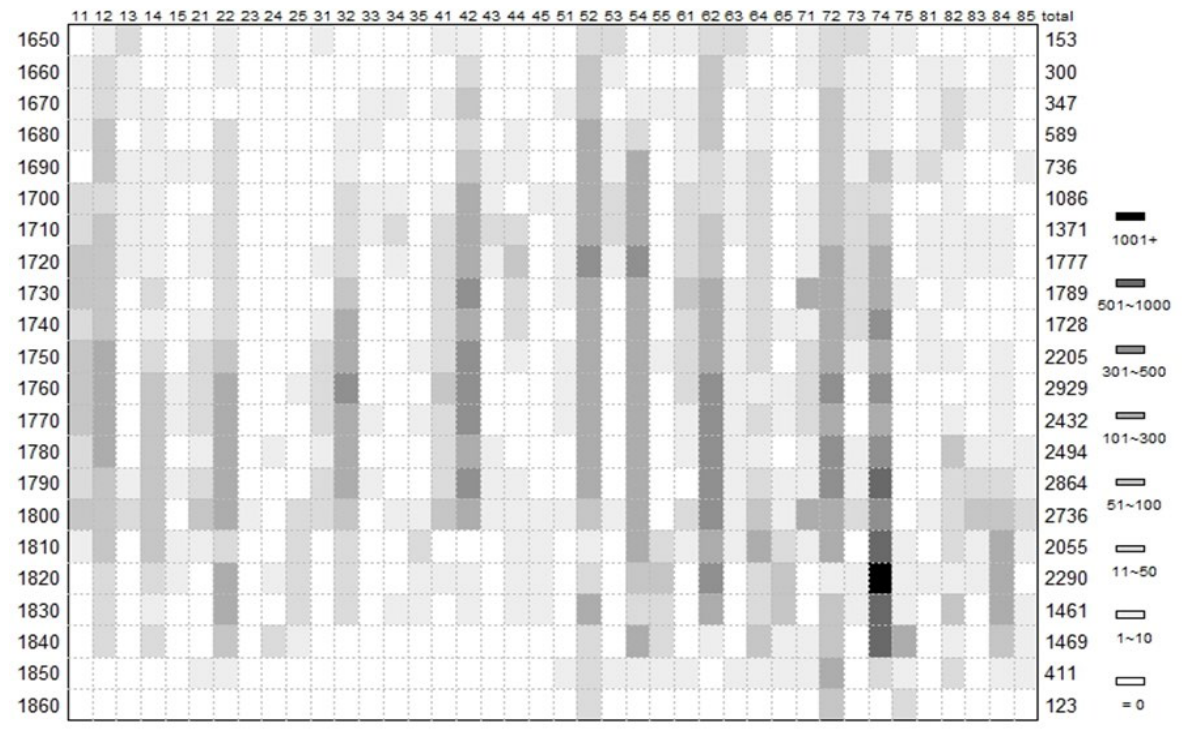
Figure 3. Voyages by route and decade (for 33,345 voyages, after regional imputation).